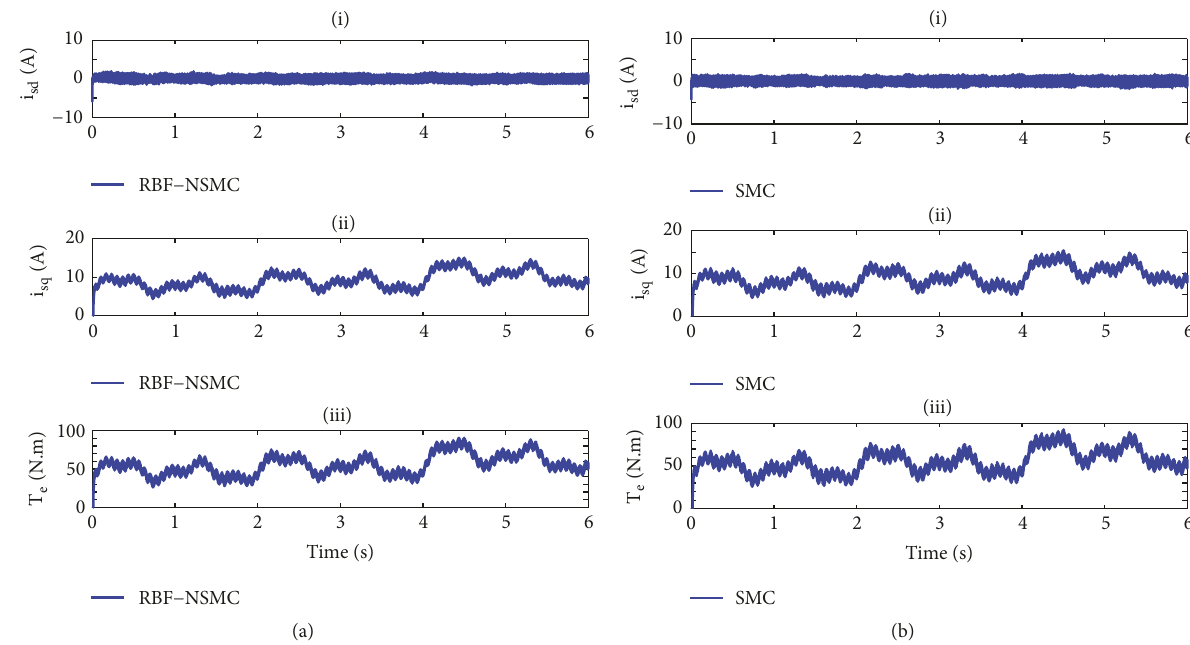
Figure 5: Control system response to wind speed fluctuations with nominal values of parameters. (a) Proposed controller. (b) Sliding mode controller. (i) Generator 𝑑− axis current. (ii) Generator 𝑞− axis current. (iii) Electromagnetic torque.